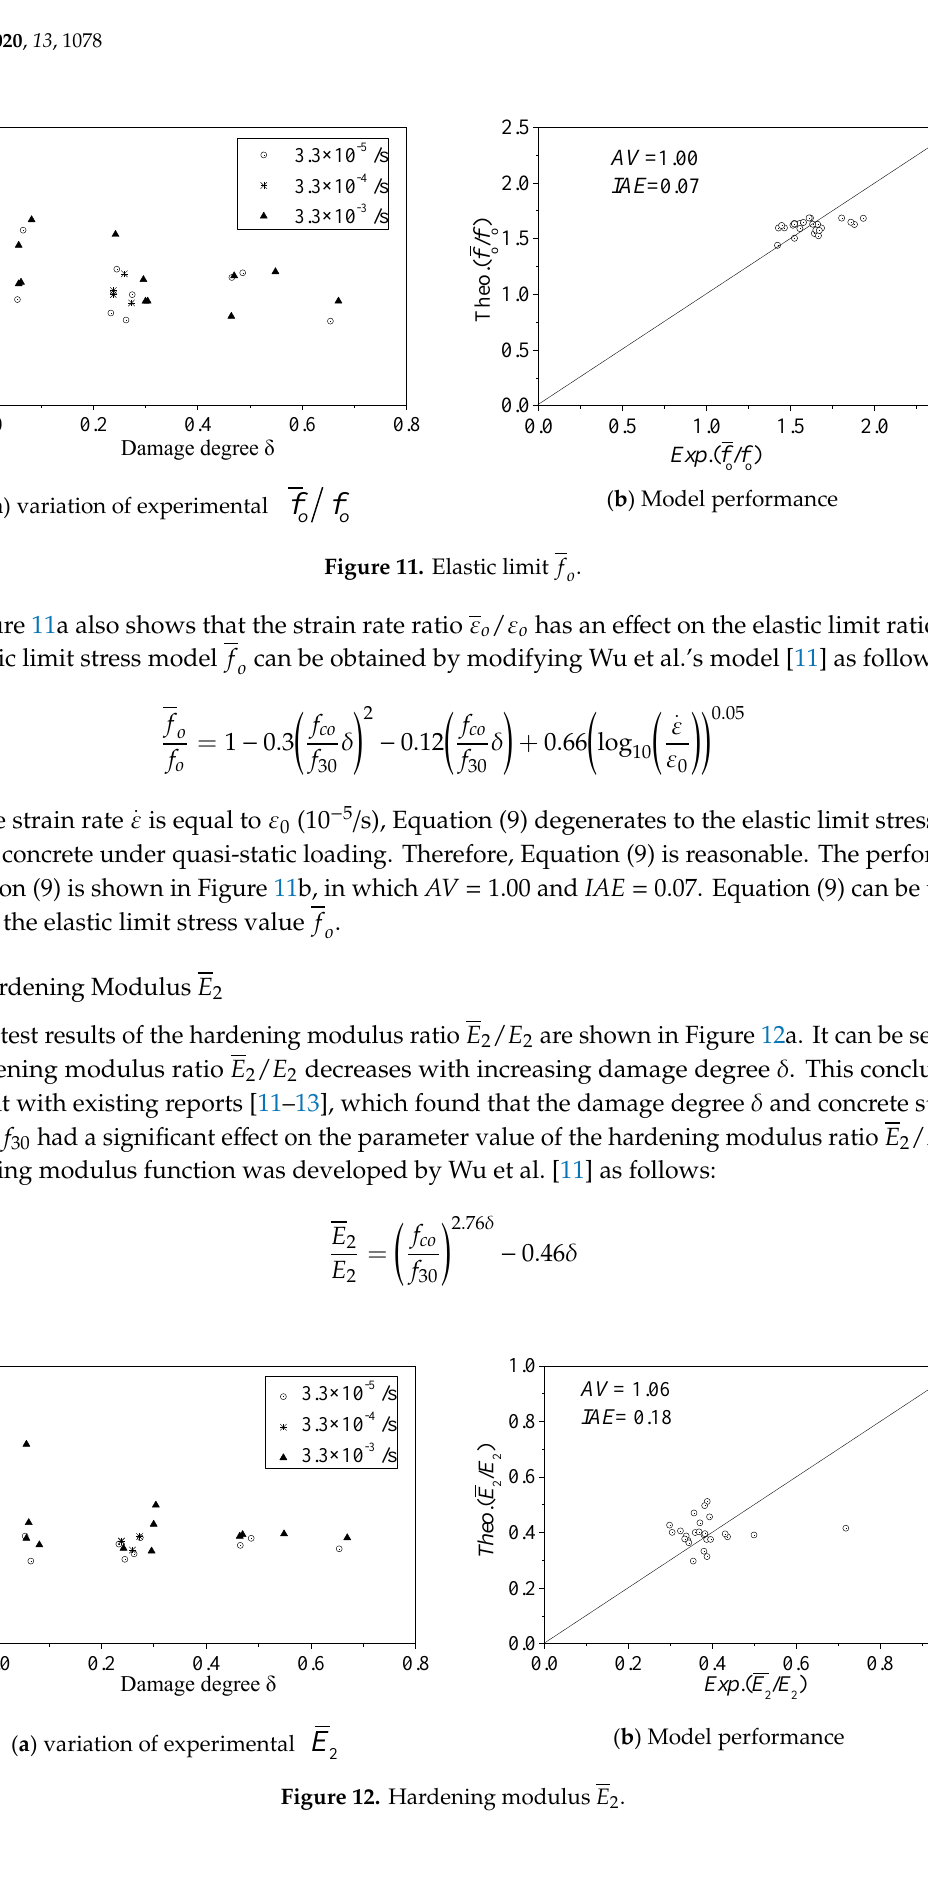
Figure 12. Hardening modulus